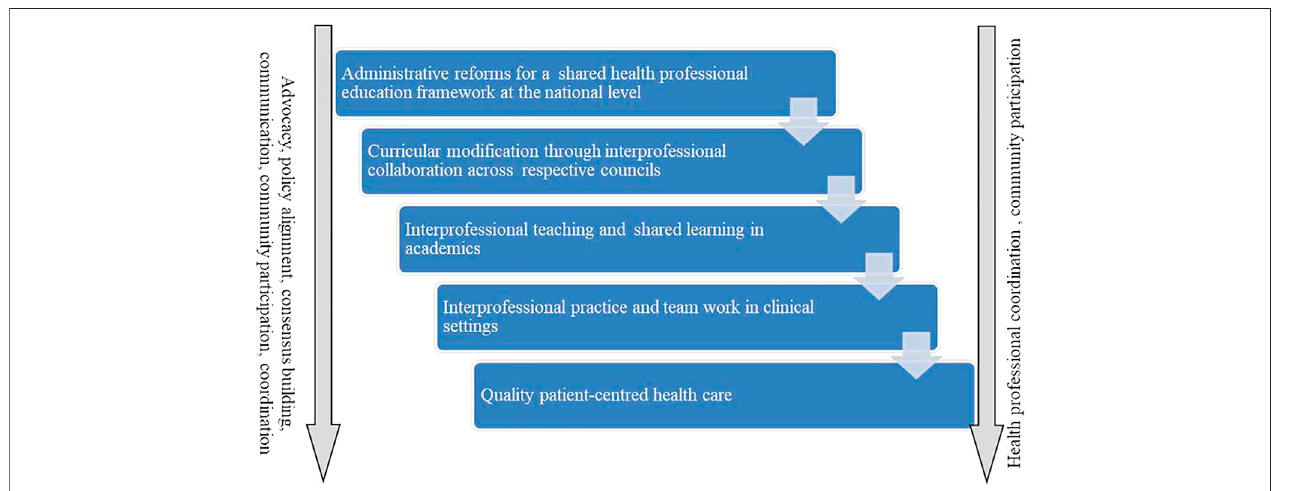
FIGURE 1 | Roadmap to the development of inter-professional care education in India.